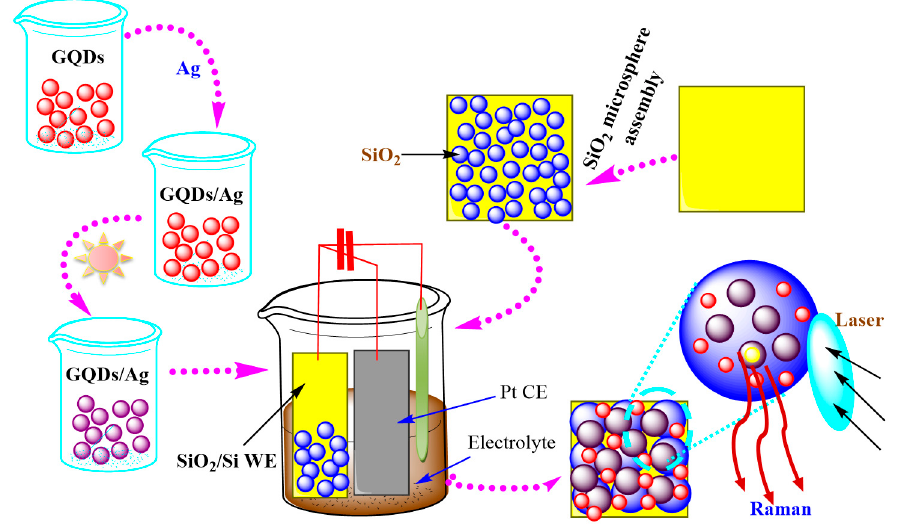
Figure 10. Formation of Ag-GQDs/SiO 2 /Si substrate.